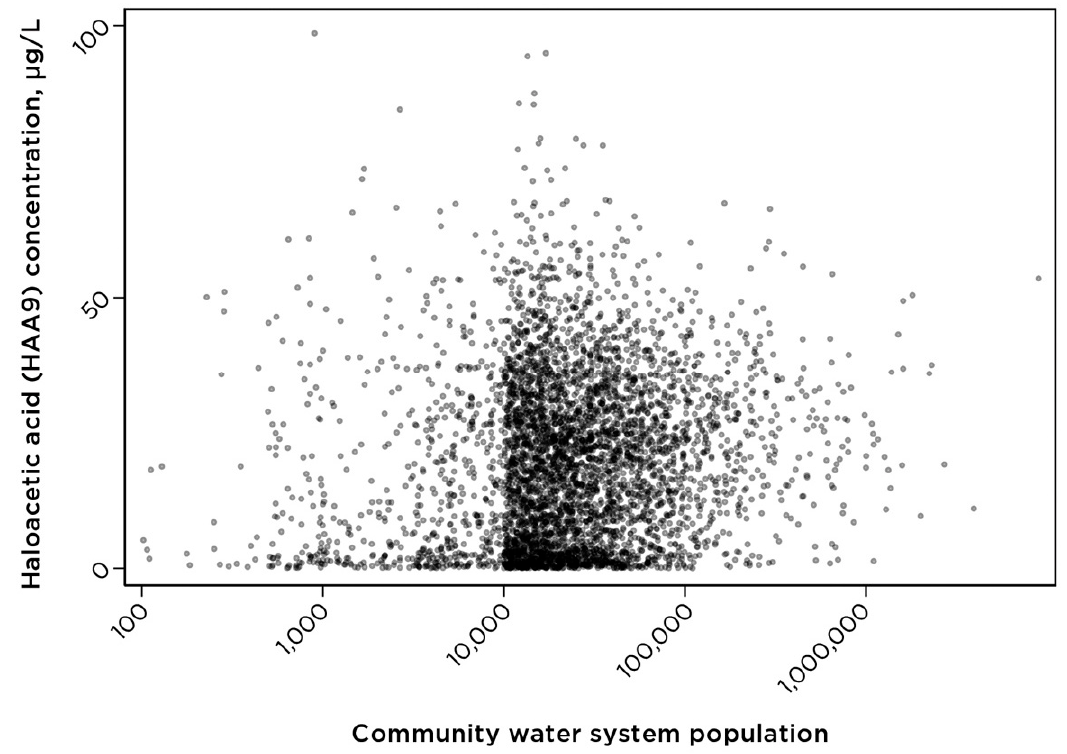
Figure 1. The concentration of 9 haloacetic acids for community water systems of different sizes. Community water systems serving less than 100 people (24 systems) and those with the concentration of HAA9 greater than 100 µ g/L (10 systems) are not shown. Information on the population served by community water systems was obtained from the U.S. EPA Envirofacts database.